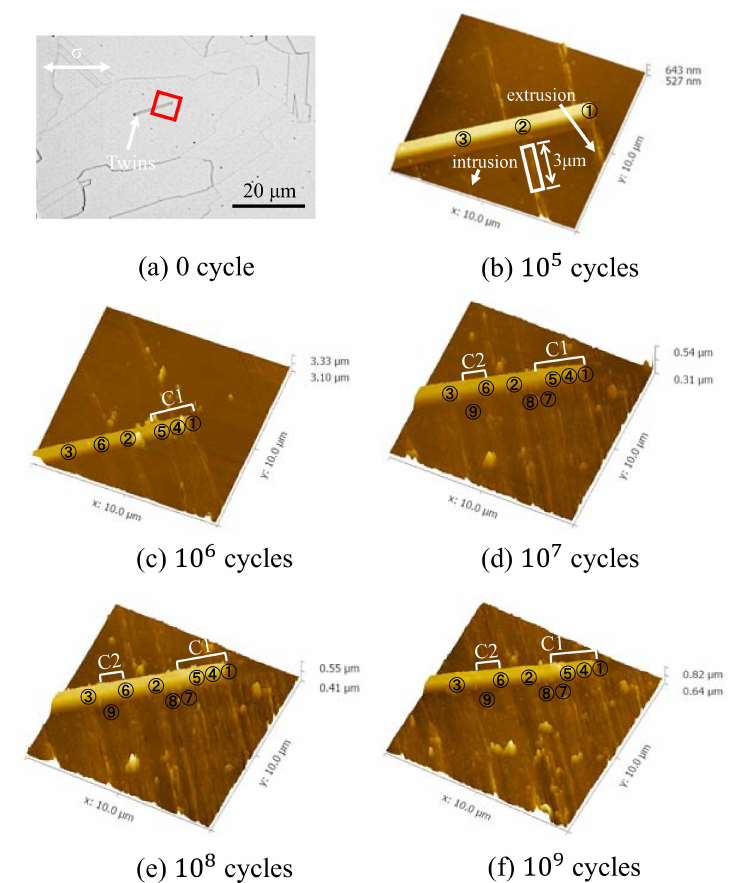
Figure 6. 3D morphology of slip bands at di ff erent fatigue cycles. ( a ) OM image. ( b – f ) AFM images. ( σ = 322